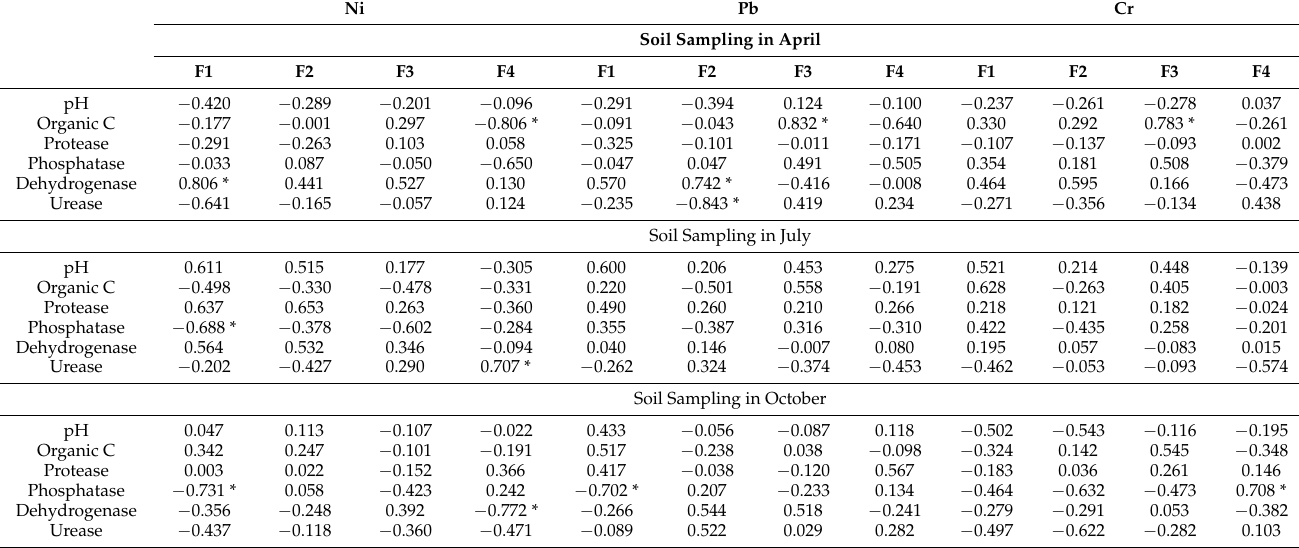
Table 5. Correlation coefficients between pH, organic carbon, enzyme activities, and fractions of Ni, Pb, and Cr in seasons ( n =